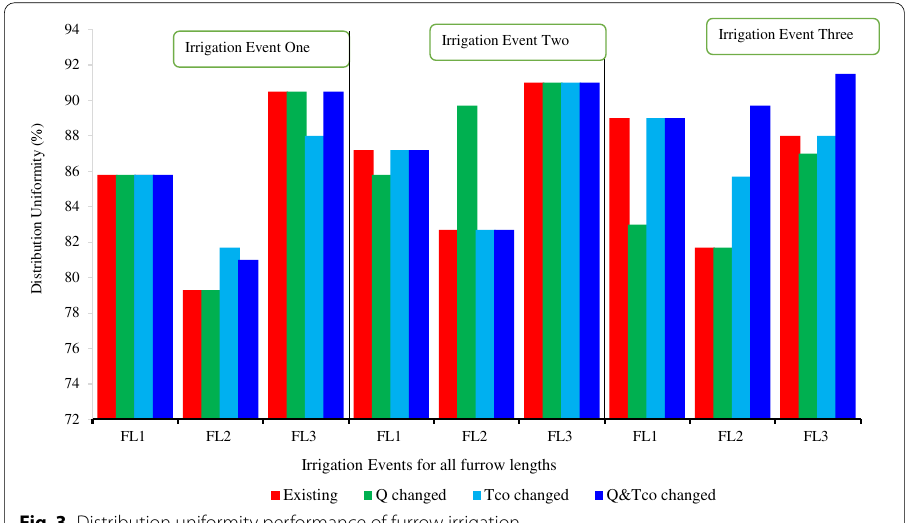
Fig. 3 Distribution uniformity performance of furrow